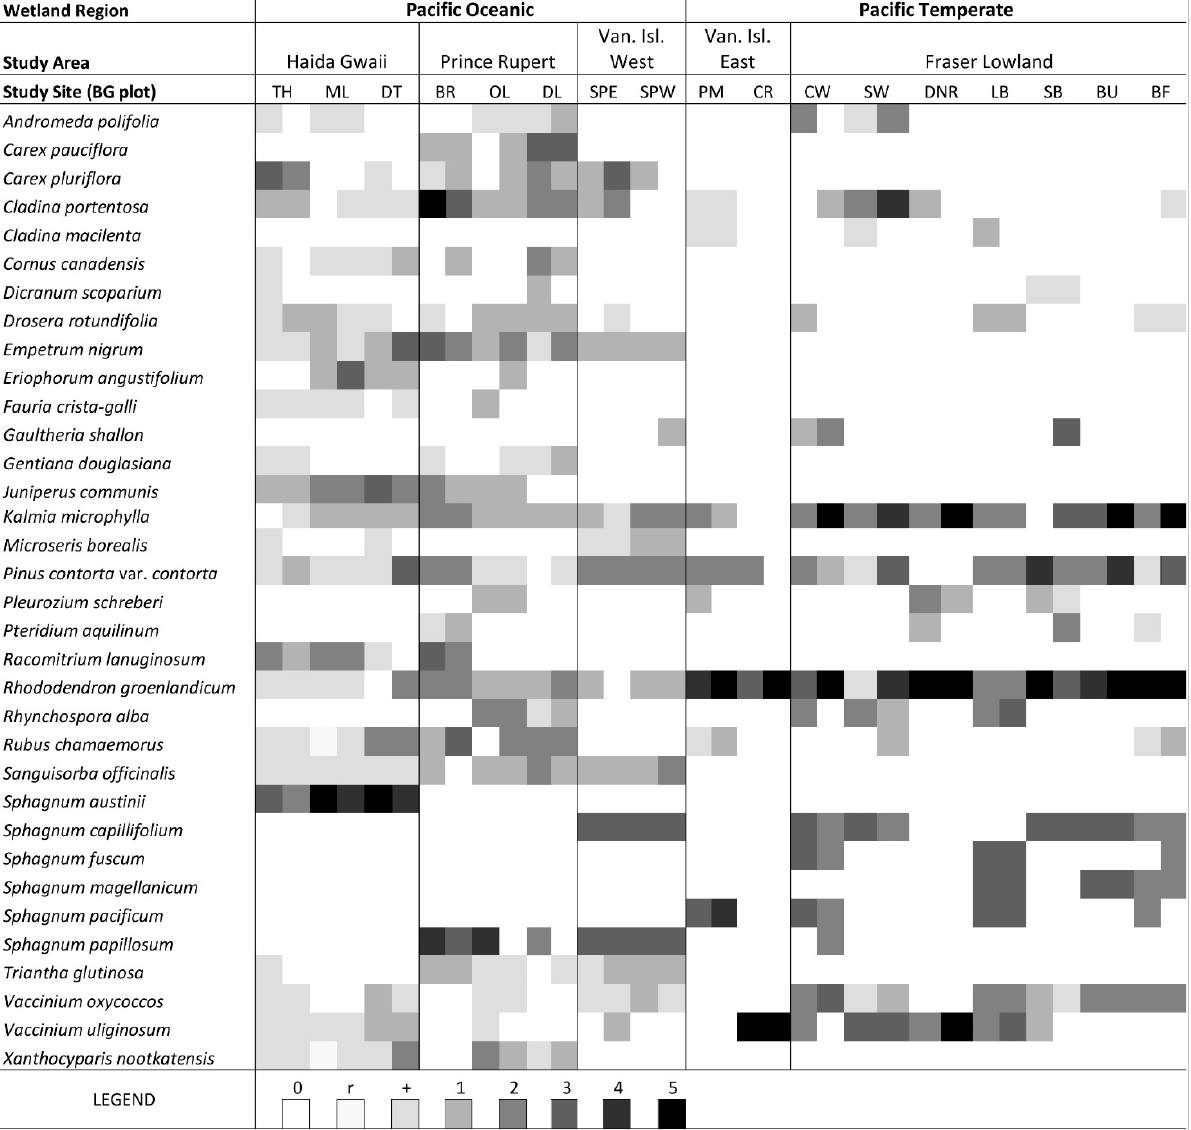
Figure 3. Species observed in at least three BG plots, with a minimum coverage ≥ 1 on the Braun-Blanquet scale in at least one plot. The squares are in pairs: the first for Transect 1, the second for Transect 2. Cover codes: “0” = absent, “r” = solitary with small cover, “+” = few with small cover, “1” = numerous but < 5 % cover, “2” = 5–25 % cover, “3” = 25–50 %, “4” = 50–75 %, “5” = ≥ 75 % (Mueller-Dombois & Ellenberg 1974). See Figure 1 for site codes. The BG plots are ordered by wetland region and study